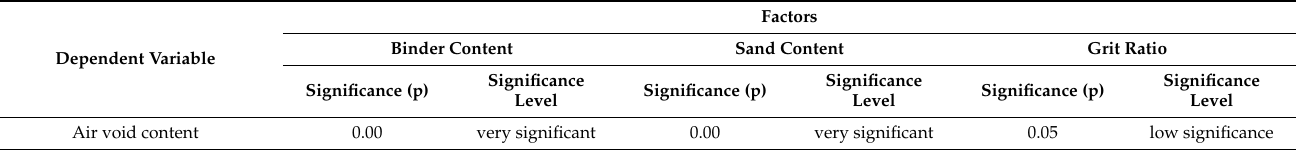
Table 3. Variance analysis results.